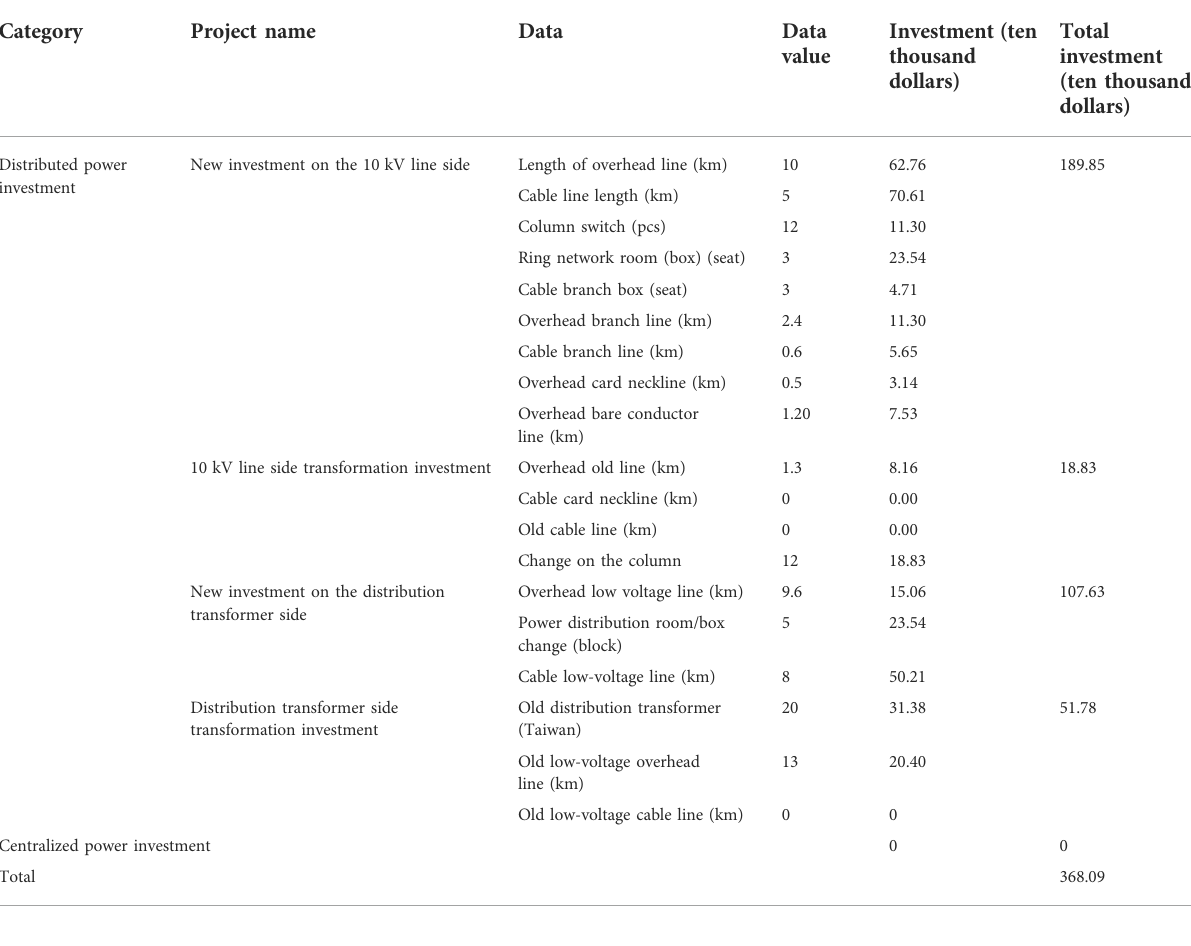
TABLE 3 Calculation results of investment scale on the power supply side.